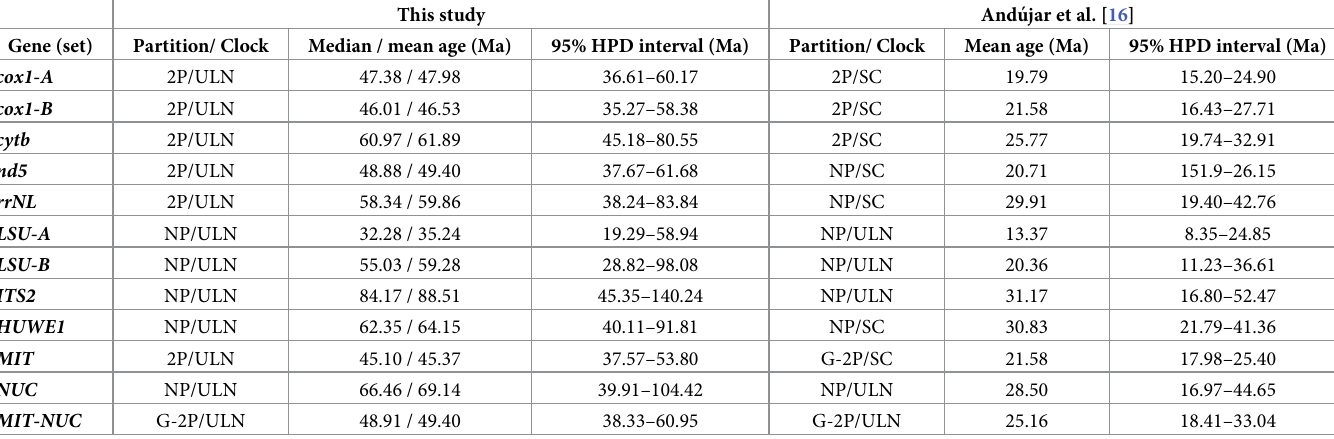
Table 4. Estimates of the molecular age of the MRCA of Carabus according to gene or gene set. This